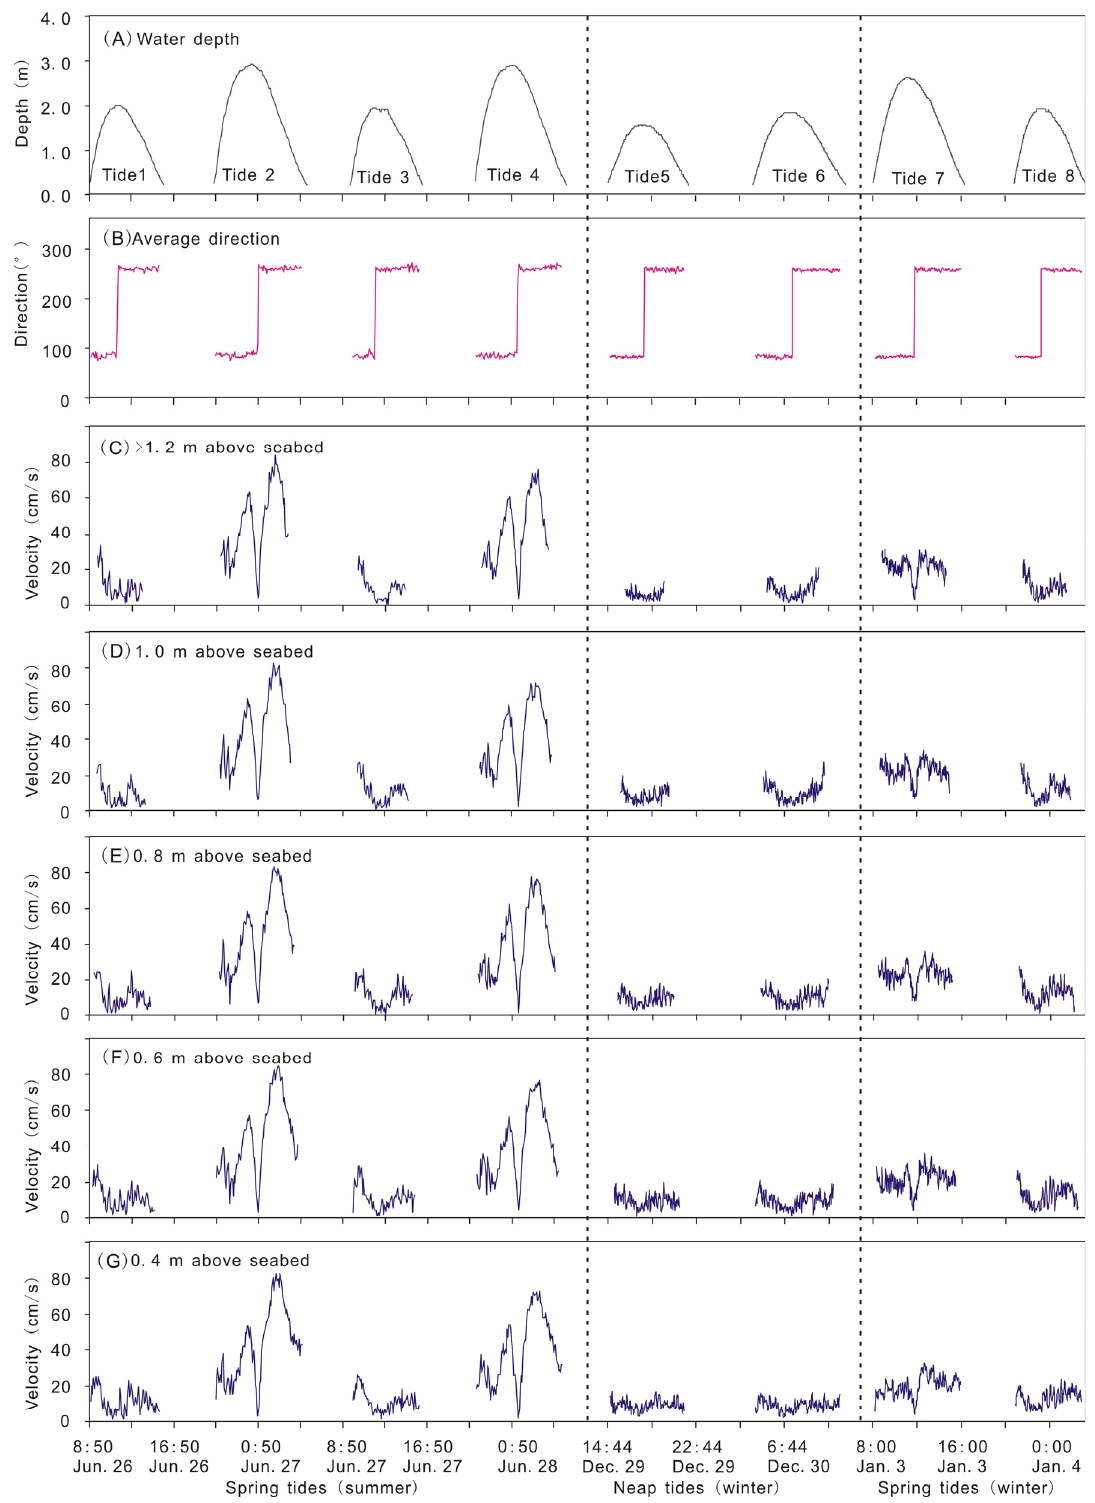
Figure 3. Time series of ( A ) water depth, ( B ) average flow direction, and ( C – G ) flow velocities at different heights above the seabed for the various seasons and tidal conditions. The velocity varied more frequently in winter than in summer because the sampling interval in winter was shorter (2 min) than that in summer (5 min). In ( C ), “>1.2 m above seabed” indicates the water surface.